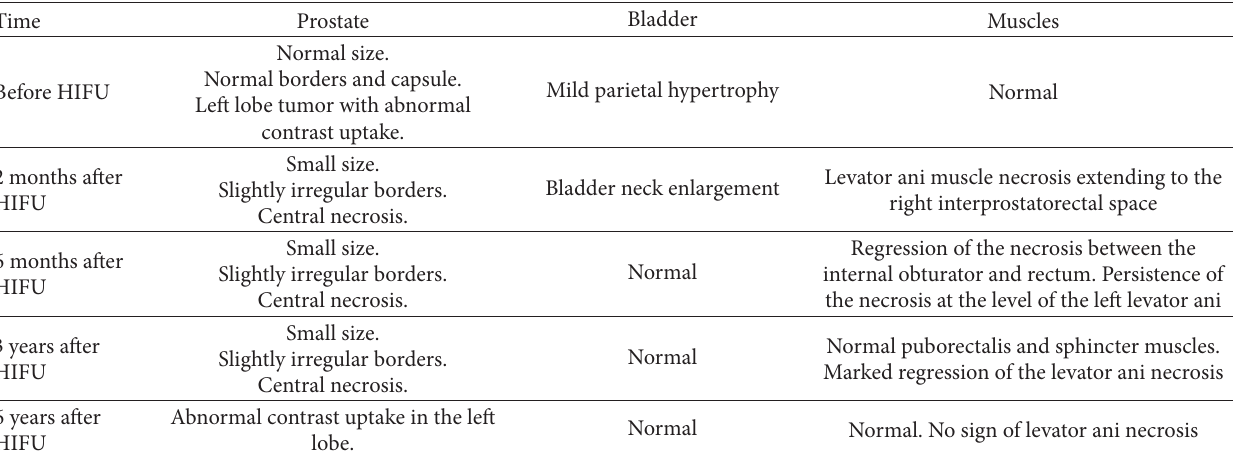
Figure 1: MRI revealing intact levator ani before HIFU (a), marked levator ani necrosis 2 months after HIFU (b), and regression of the levator ani necrosis after 3 years (c). Table 1: Pelvic MRI follow-up after